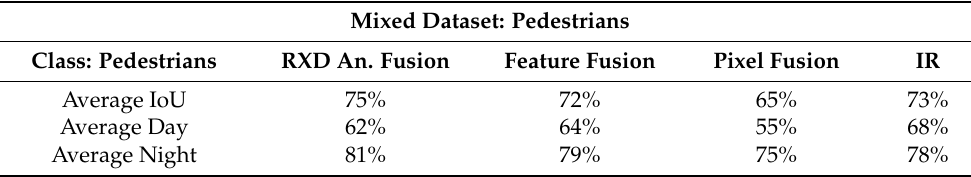
Table 6. IoU scores for pedestrians’ classification by networks trained with Mixed DS of the different processes compared to IR scores. Average IoU score is of all images in the datasets; average day and average night separately sum the relative score for daylight images and for nightlight images out of the mixed DS, respectively. IoU scores are calculated in relation to GT